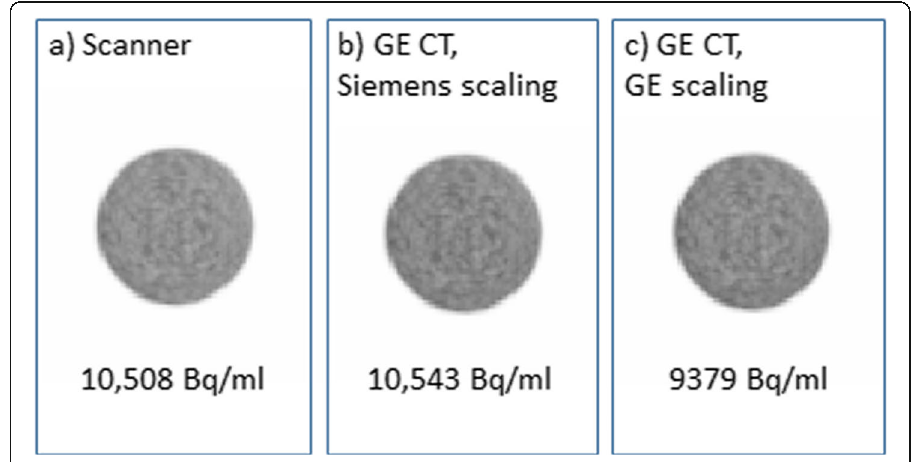
Fig. 6 Images of the 68 Ge daily QC phantom attenuation corrected using a CT provided on the scanner, b GE CT with Siemens HU to LAC scaling and c GE CT with GE HU to LAC scaling. The activity concentration measured in a large ROI located at the centre of the images is shown below each